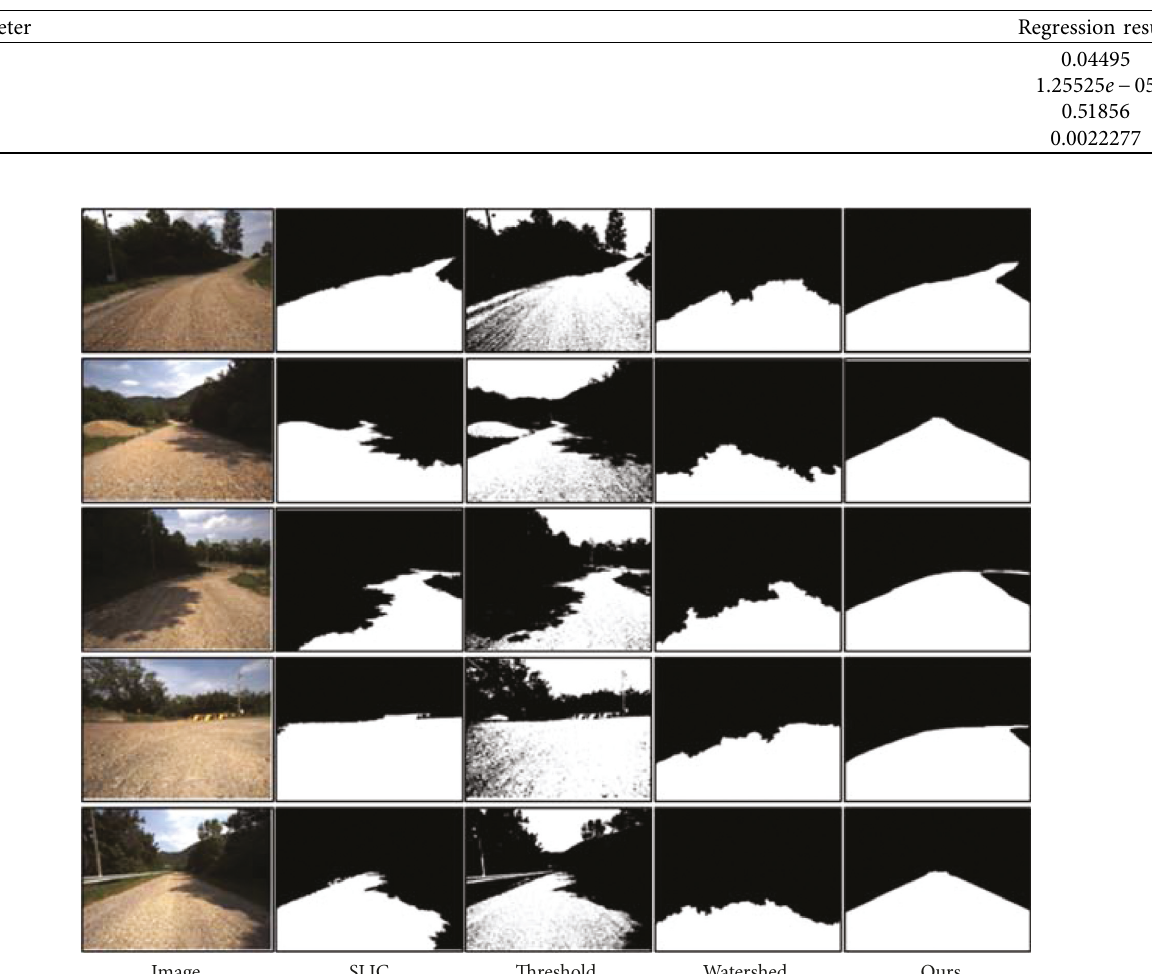
Table 2: Results of dynamic